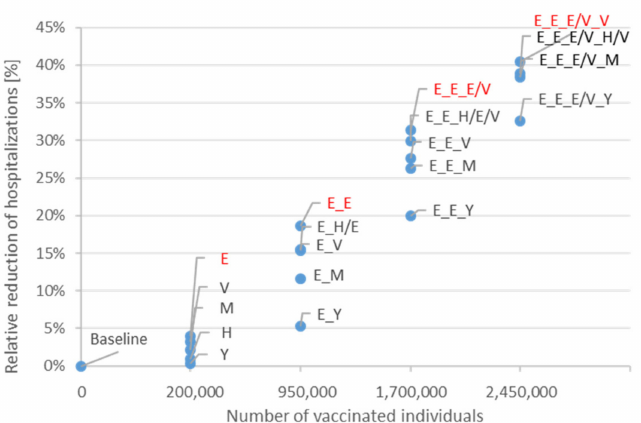
Figure A2. Cumulative relative reduction of hospitalizations for each stepwise optimization step for a vaccine inducing non-sterilizing immunity in comparison to no vaccination (maximizing relative reduction in deaths). E—elderly ( ≥ 65 years); H—healthcare workers; M—middle-aged persons (45–64 years); V—vulnerable, individuals with increased risk of severe disease once infected; and Y—persons of younger age (15–44 years). Vaccination strategies are described by stepwise provision of vaccines to population groups. For example, E_E_Y means that with the first batch 200,000 elderlies were vaccinated, followed by the second batch to vaccinate again 750,000 elderlies and followed by the third batch to vaccinate 750,000 persons of younger age. A split of a batch among two population groups is symbolized by /. The strategy colored in red provided the best outcome in terms of relative reduction of deaths in the stepwise optimization as evaluated and displayed in Figure A1. The analysis assumed a vaccine effectiveness of 70% in the general population and of 60% in the age group 65+.